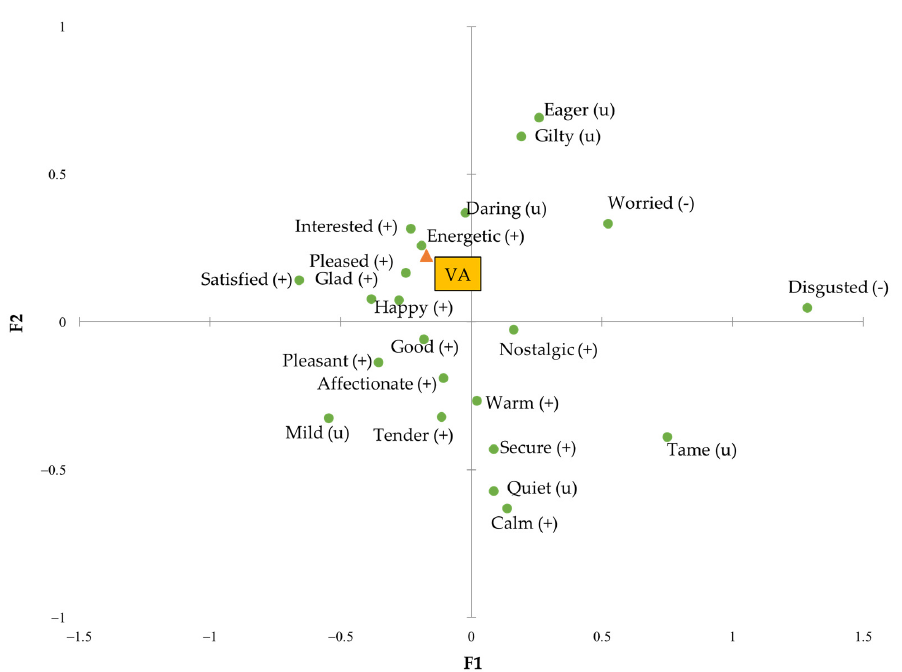
Figure 4. Principal coordinates analysis with the variable “Visual acceptance” (VA) of the significant emotional responses obtained with CATA EsSense Profile ® . Note: (+): positive emotion; ( − ): negative emotion; (u): neutral emotion.